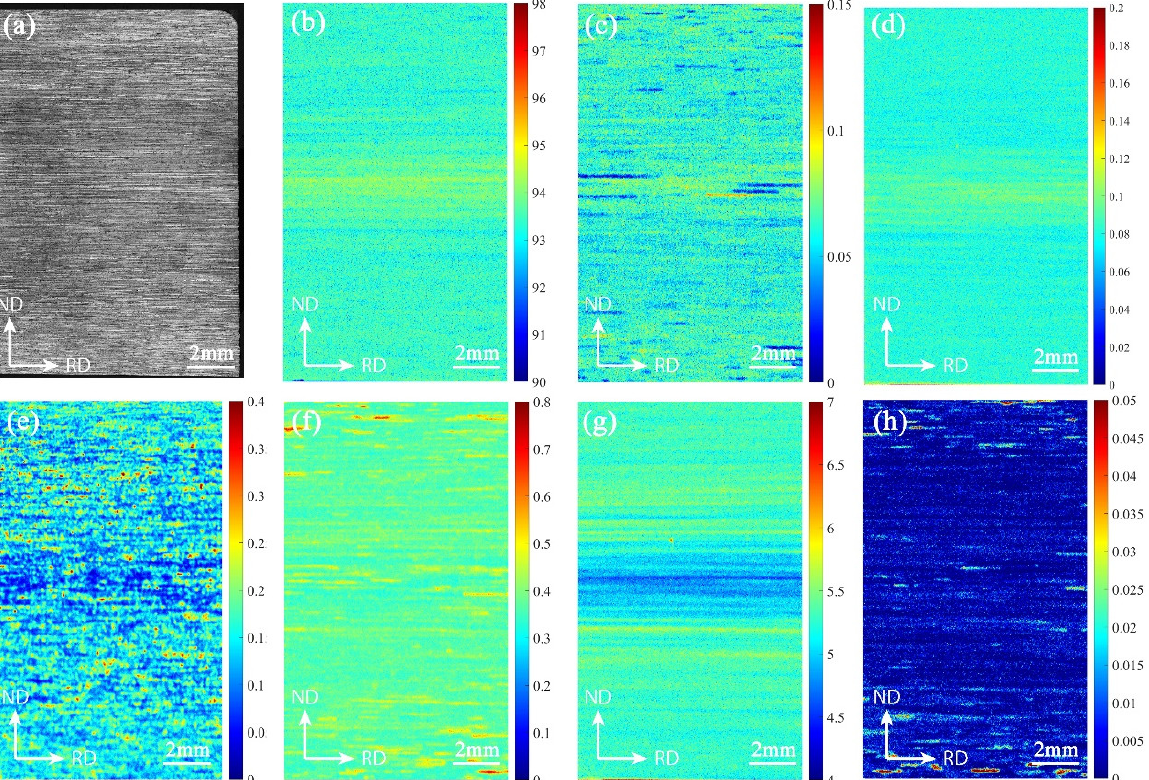
Figure 7. The mapping of T4-15 element contents measured by X-ray fluorescence: ( a ) sample; ( b ) Al element; ( c ) Cr element; ( d ) Zr element; ( e ) Fe element; ( f ) Mn element; ( g ) Zn element; ( h ) Cu element.